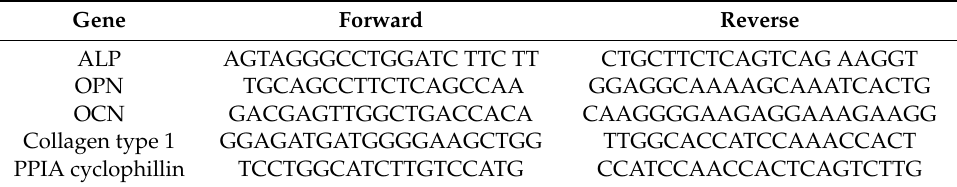
Table 2. Primer sequence of osteogenic